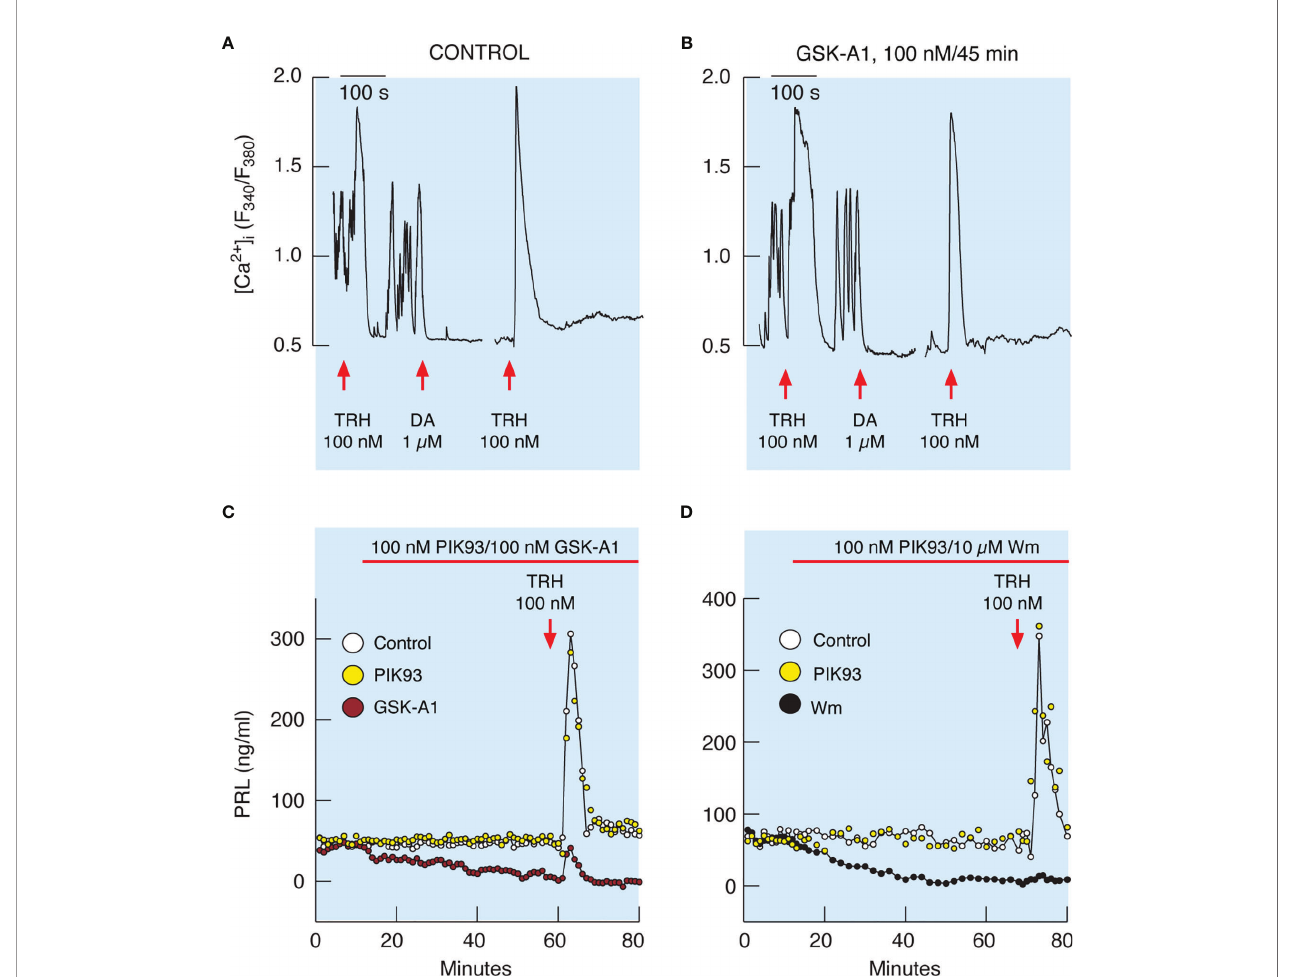
FIGURE 9 | Inhibition of PI4KA blocks TRH-stimulated PRL release downstream of TRH-induced calcium mobilization from intracellular pools. (A, B) To identify single lactotrophs, control (A) and GSK-A1-pretreated (B) cells were treated with TRH and dopamine (DA), washed for 15 min, and restimulated with TRH. GSK-A1 was added 45 min before recording, during TRH and DA treatments, and during the rinsing periods. DA blocks voltage-gated calcium in fl ux, which is also a useful pharmacological tool for demonstrating extracellular calcium independence of spike response and extracellular calcium dependence of sustained calcium transients, as shown by another application of TRH in the presence of dopamine. Traces shown are representative from three independent experiments. (C, D) TRH-induced PRL release was dramatically reduced in GSK-A1- and Wm-treated cells, but not in PIK93-treated cells. Mean ± SEM values (ng/ml) during 20 min TRH application were: (C) TRH 107 ± 14 ng/ml, GSK-A1+ TRH = 14 ± 3 (P < 0.0001), and PIK+TRH 107 ± 15; (D) TRH 172 ± 31 ng/ml, Wm + TRH = 10 ± 1 (P < 0.0001), and PIK93+TRH 205 ±